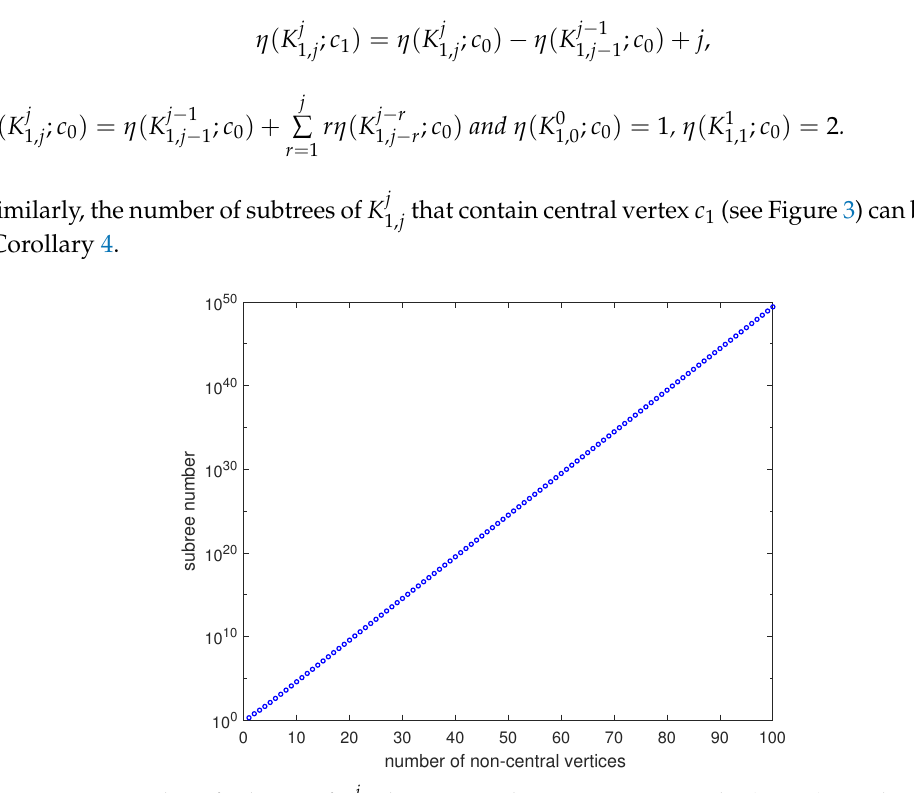
Figure 3. Number of subtrees of K j